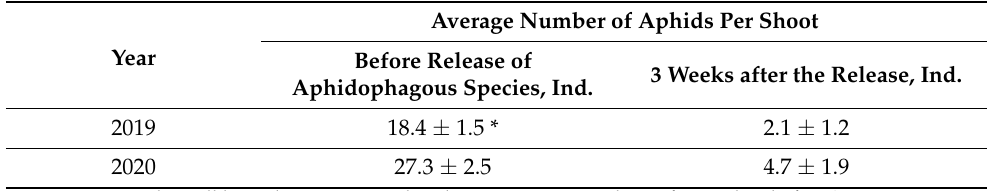
Table 8. Effectiveness of aphidophagous species against aphids (Shcherbakov farm, 2019–2020). Average Number of Aphids Per Shoot 3 Weeks after the Release, Year before Release of Aphidophagous Species, Ind.